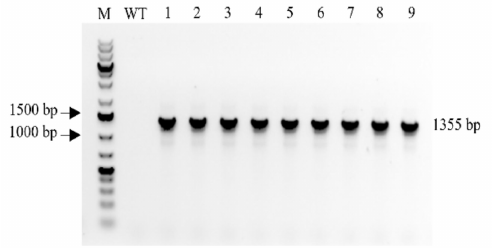
Figure 1. PCR amplification of a 1355 bp fragment of MBP::rhLL-37 gene from barley genomic DNA. M, 1 kb plus DNA ladder; WT, Wild type (non-transformed barley plant); lane 1, T5 and lanes 2–9, T6 progenies of a homozygous MBP::rhLL-37 transgenic barley line.